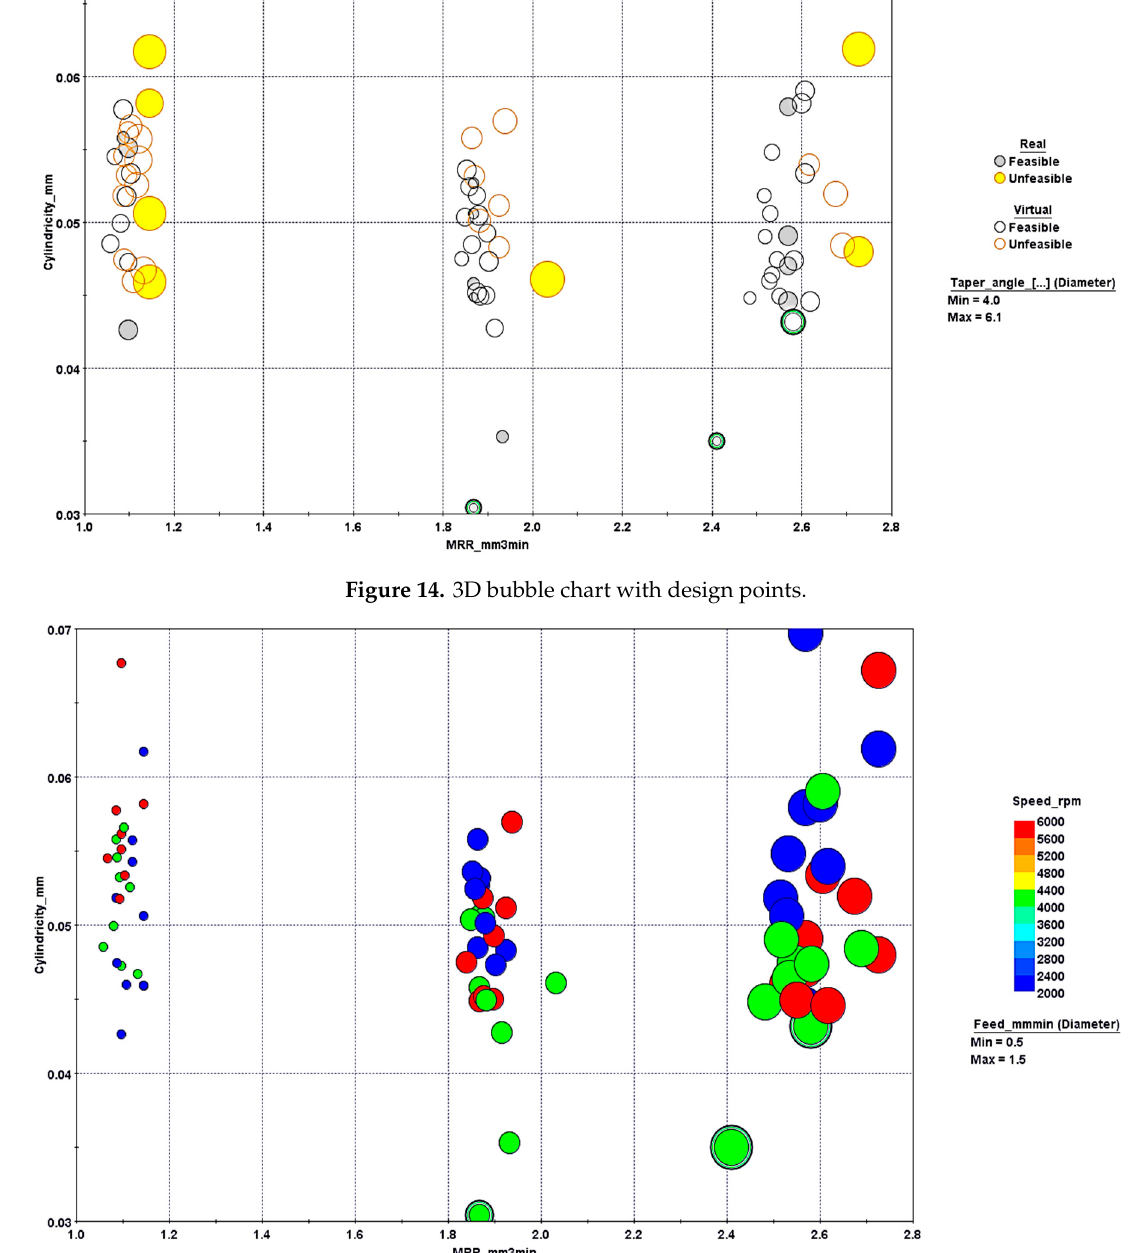
Figure 15. E ff ects of speed and feed rate in a 4D bubble Figure 15. Effects of speed and feed rate in a 4D bubble chart Figure 15. Effects of speed and feed rate in a 4D bubble chart